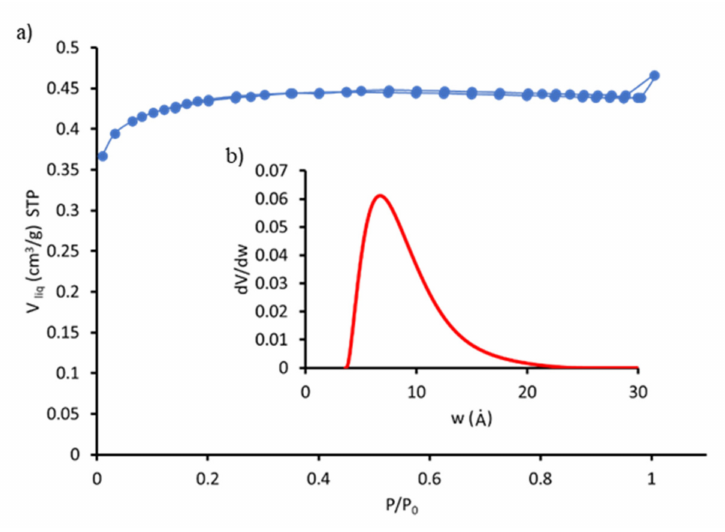
Figure 3. ( a ) N 2 adsorption–desorption isotherm and ( b ) pore size distribution. The surface chemistry was analyzed by XPS and FTIR. C 1s , O 1s , and N 1s spectral regions are depicted in Figure 4 and data by deconvolution of these regions are collected in Table 2. The C 1s spectral region can be fitted using six peaks: at 284.6 eV attributed to nonoxygenated amorphous carbon, at 285.6, 286.3, 287.3, and 288.9 eV assigned to alcohol and ether (C-O), carbonyl (C=O), carboxyl (COO-), and carbonate groups, respectively, and a weak peak found at 291.4 eV assigned to π -plasmon excitations. In turn, the O 1s region shows three peaks centered at 531.5 eV, characteristic either of a bonded hydroxyl group (–OH) or